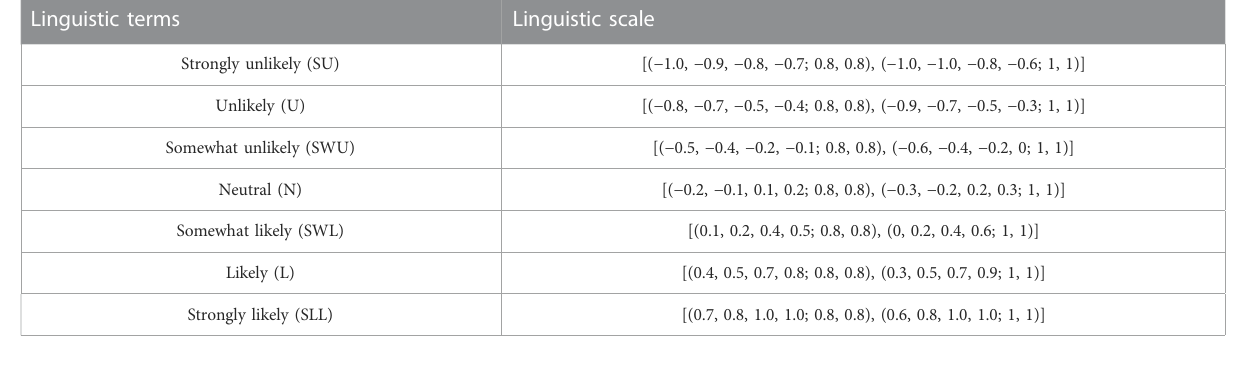
TABLE 2 Linguistic scale of reliability for the extended IT2FVIKOR. Linguistic terms